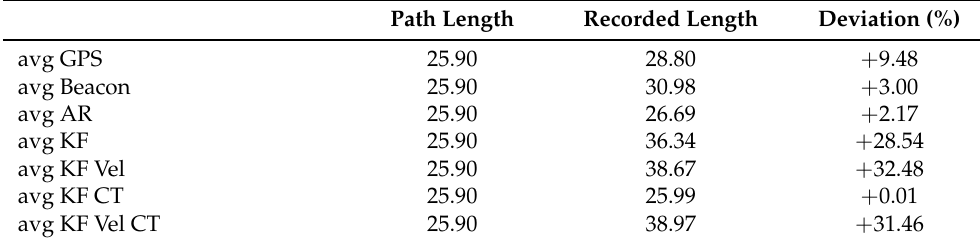
Table 13. Evaluation (Data Set 2); GPS and Beacon and AR; Length related